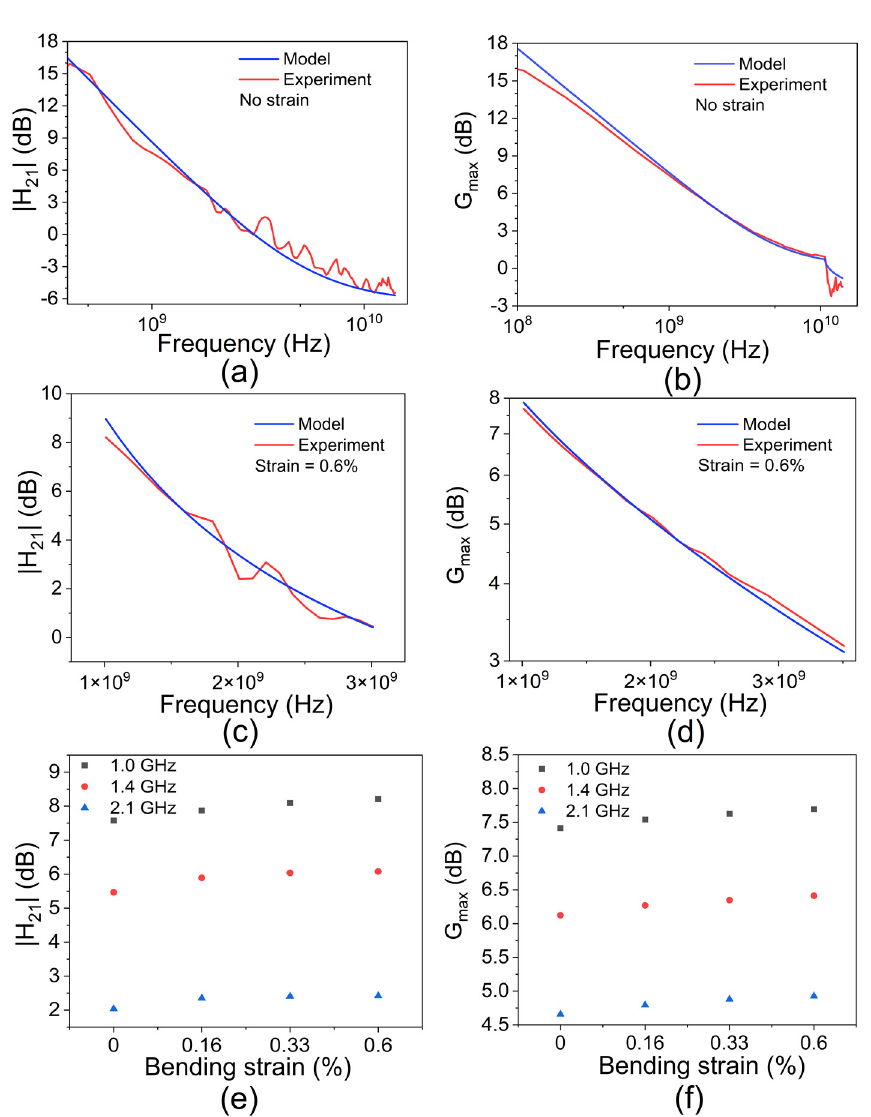
Figure 2. Comparison of the measured and the simulated ( a ) H 21 and ( b ) G max of the flat TFT. Comparison of the measured and the simulated ( c ) H 21 and ( d ) G max of the TFTs with 0.6% bending strains (1–3 GHz). Measured ( e ) H 21 and ( f ) G max of the TFTs with different bending strains (1.0, 1.4, and 2.1 GHz).